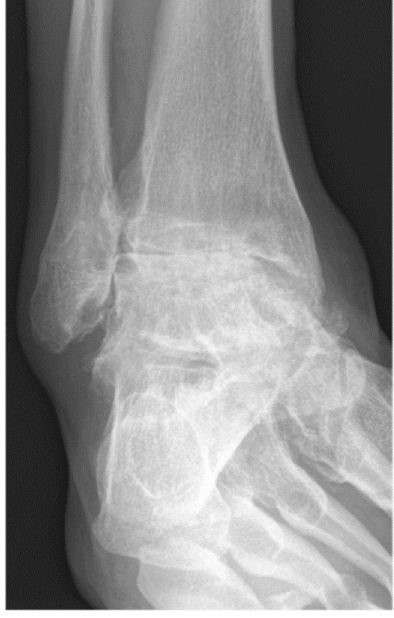
Figure 1. A 57-year-old male patient presenting end-stage varus tibiotalar osteoarthritis.